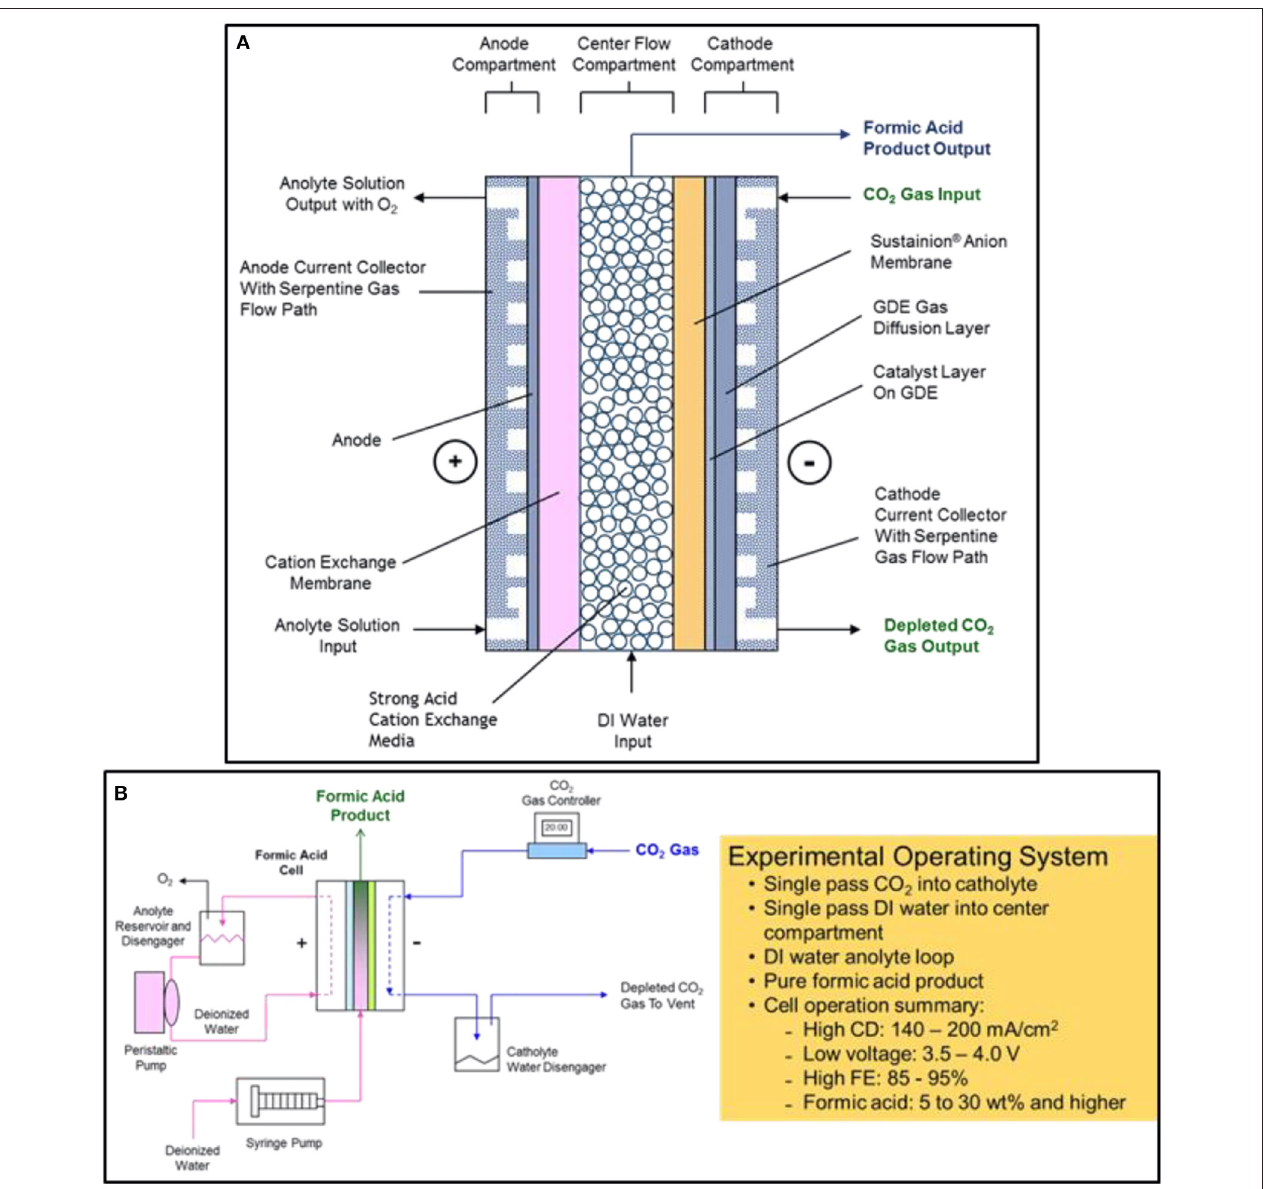
FIGURE 2 | The electrochemical three compartment formic acid cell design configuration is shown in (A) . The experimental formic acid cell operating system and performance summary is shown in (B)